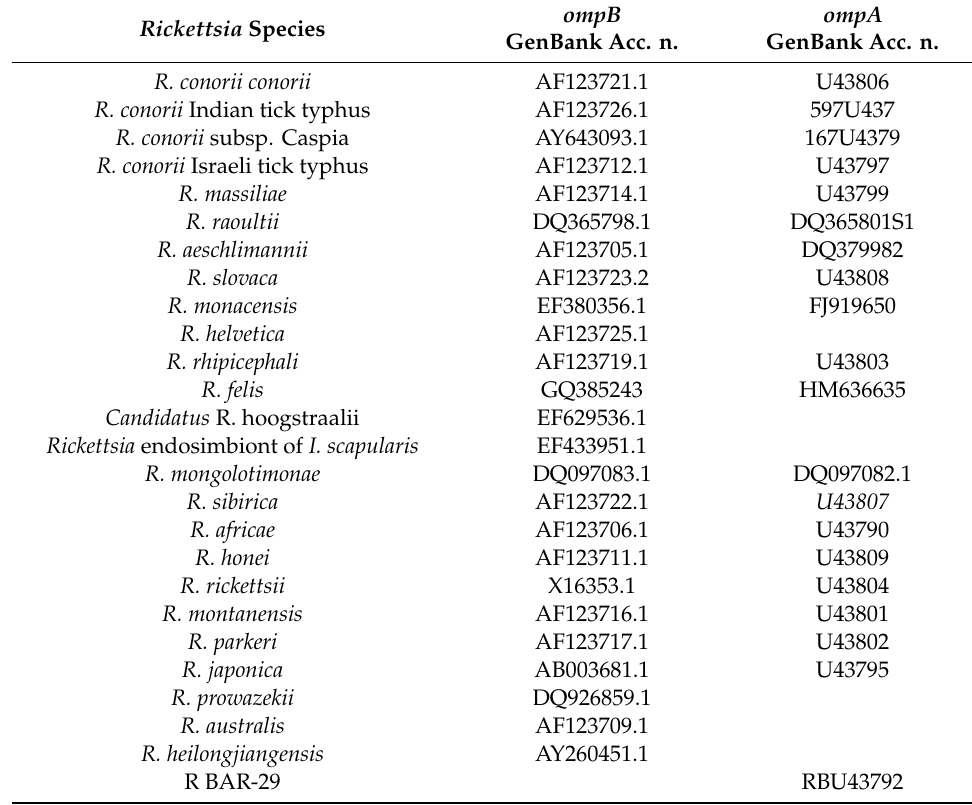
Table 2. Accession numbers of ompB and ompA gene sequences from many di ff erent Rickettsia species selected from GenBank and used in this study for primer and probe design and for in silico specificity